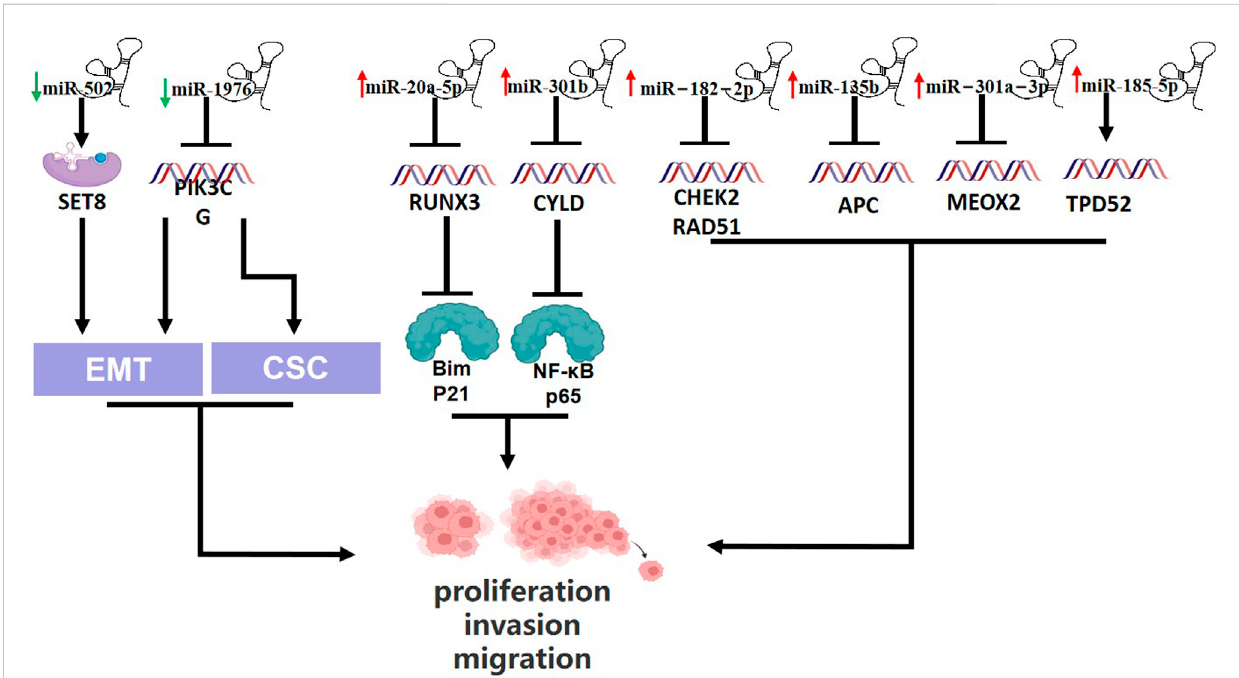
FIGURE 2 Schematic presentation of miRNAs involvement in promotion of triple-negative breast cancer and relationship between miRNAs and epithelial-to mesenchymal transition (EMT) and Cancer stem cells-like properties (CSC). Downregulated miR-502 enhance SET8 expression, which promotes EMT. miR-1976 knockdown could enhance EMT and CSCs by blocking PIK3CG. Upregulation of miR-20a-5p suppresses RUNX3, which suppresses Bim and p21. miR-301b is upregulated and represses CYLD, which block NF-KB p65. And high expression of miR-182-2p suppresses CHEK2 and RAD51. Upregulated miR-135b, miR-301a-3p and miR-185-5p block APC, MEOX2 and TPD52,